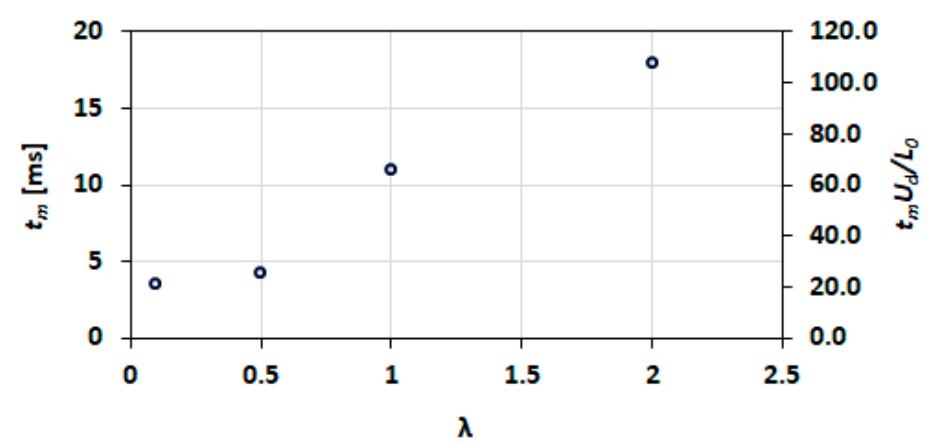
Figure 31. Influence of the viscosity ratio on mixing time and dimensionless mixing distance.